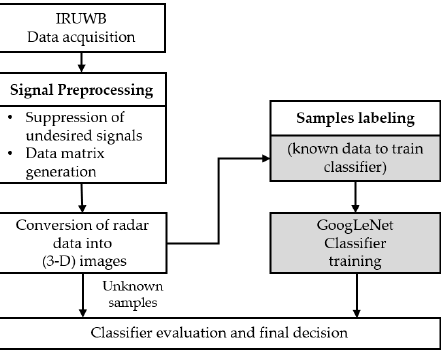
Figure 1. Training and evaluation process of the proposed hand gesture recognition framework for impulse-radio ultra-wideband (IR-UWB) radars.